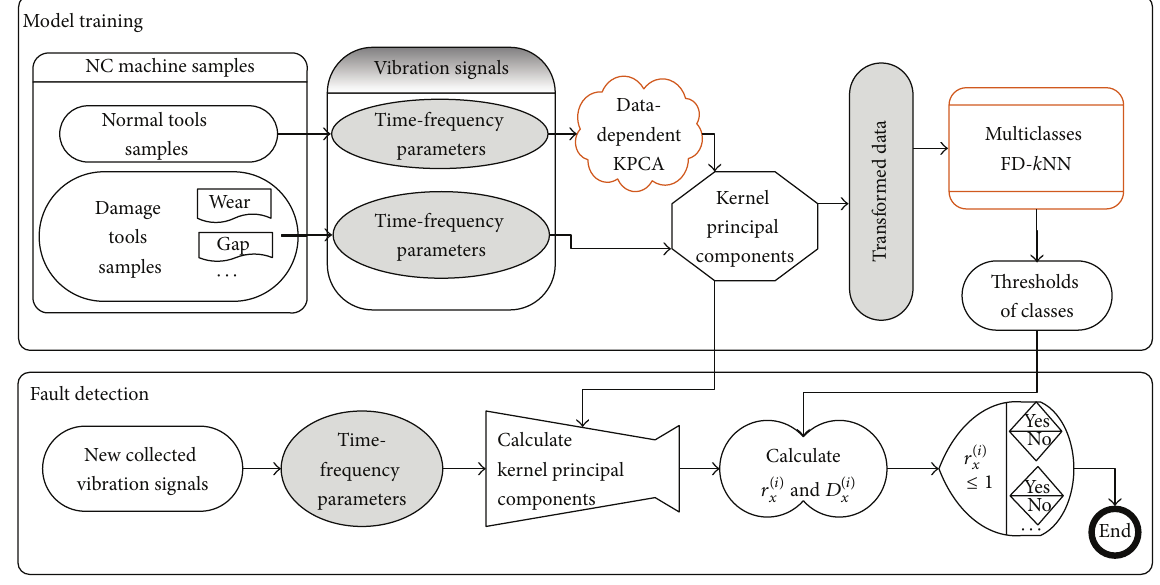
Figure 1: Sketch of fault diagnosis process for NC machine tools based on KPCA and MFD- 𝑘 NN.